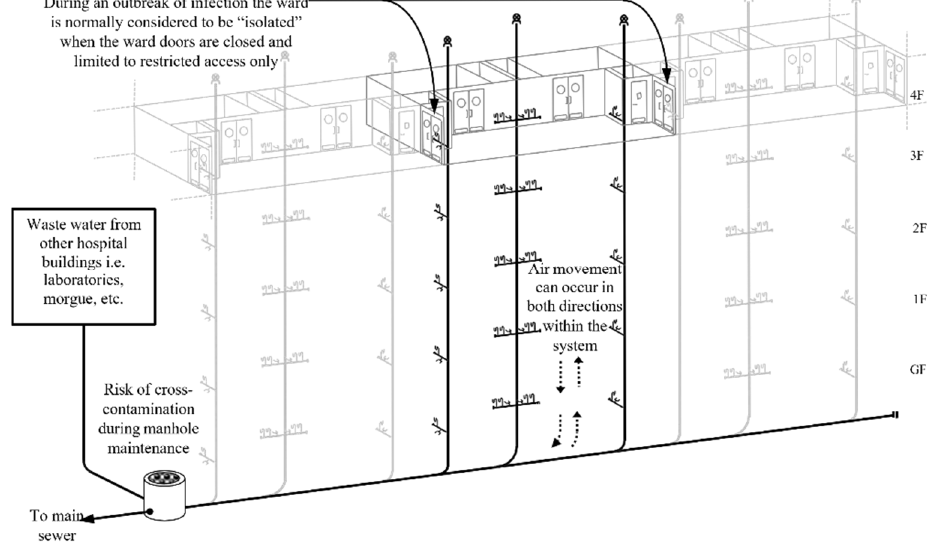
Figure 3. Interconnection of entire building through the building drainage system [37].